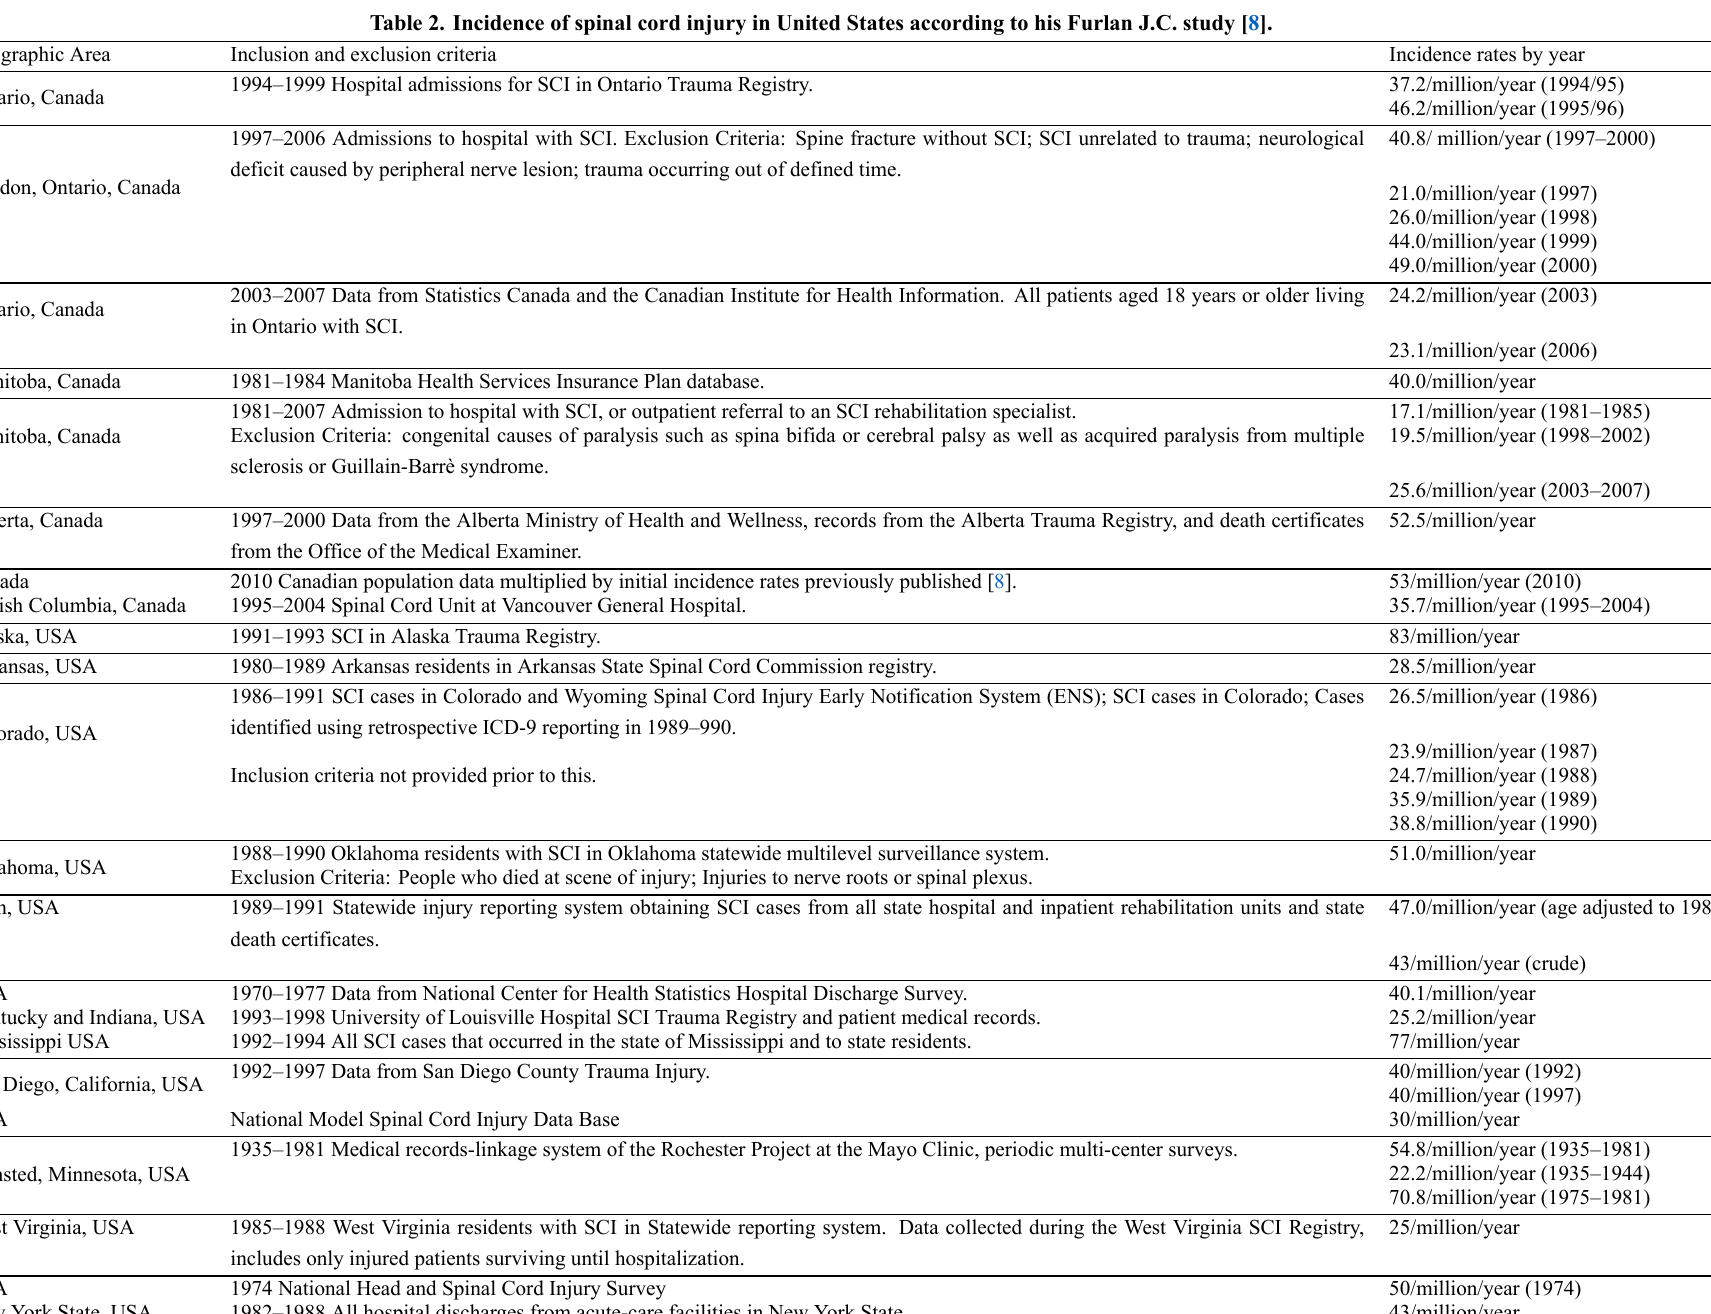
Table 2. Incidence of spinal cord injury in United States according to his Furlan J.C. study